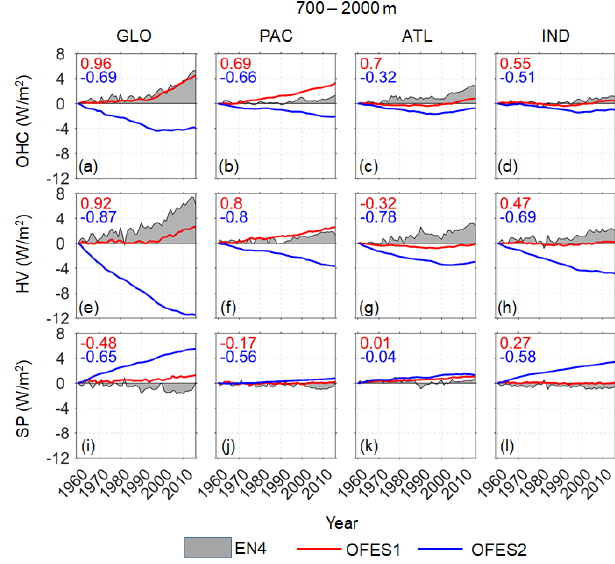
Figure 4. As for Fig. 2 but for the lower layer